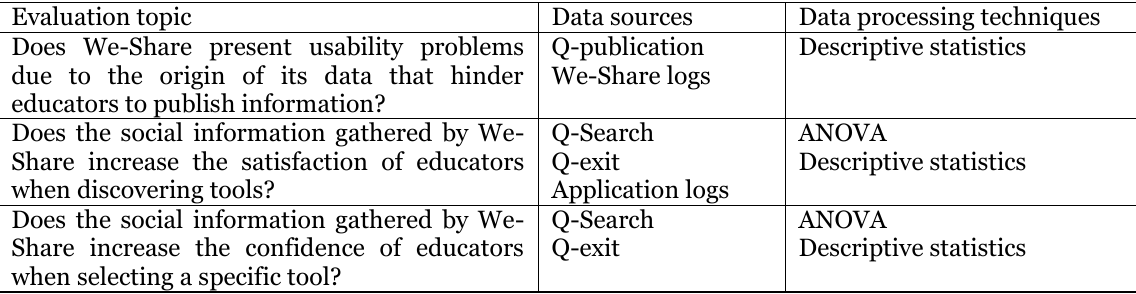
Summary of Evaluation Topics, Data Sources, and Data Processing Techniques Evaluation